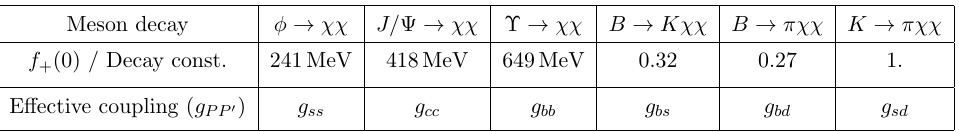
Table 4 . Form factors f + (0) in the case of pseudo-scalar mesons decay from [18, 50] of the form P 0 ! P(cid:31)(cid:31) and e(cid:11)ective decay constant for the (cid:13)avoured vector meson decay from [51], as well as the relevant e(cid:11)ective couplings ( g PP 0 ) for the various heavy meson decays through vector currents, presented in section 2.2.